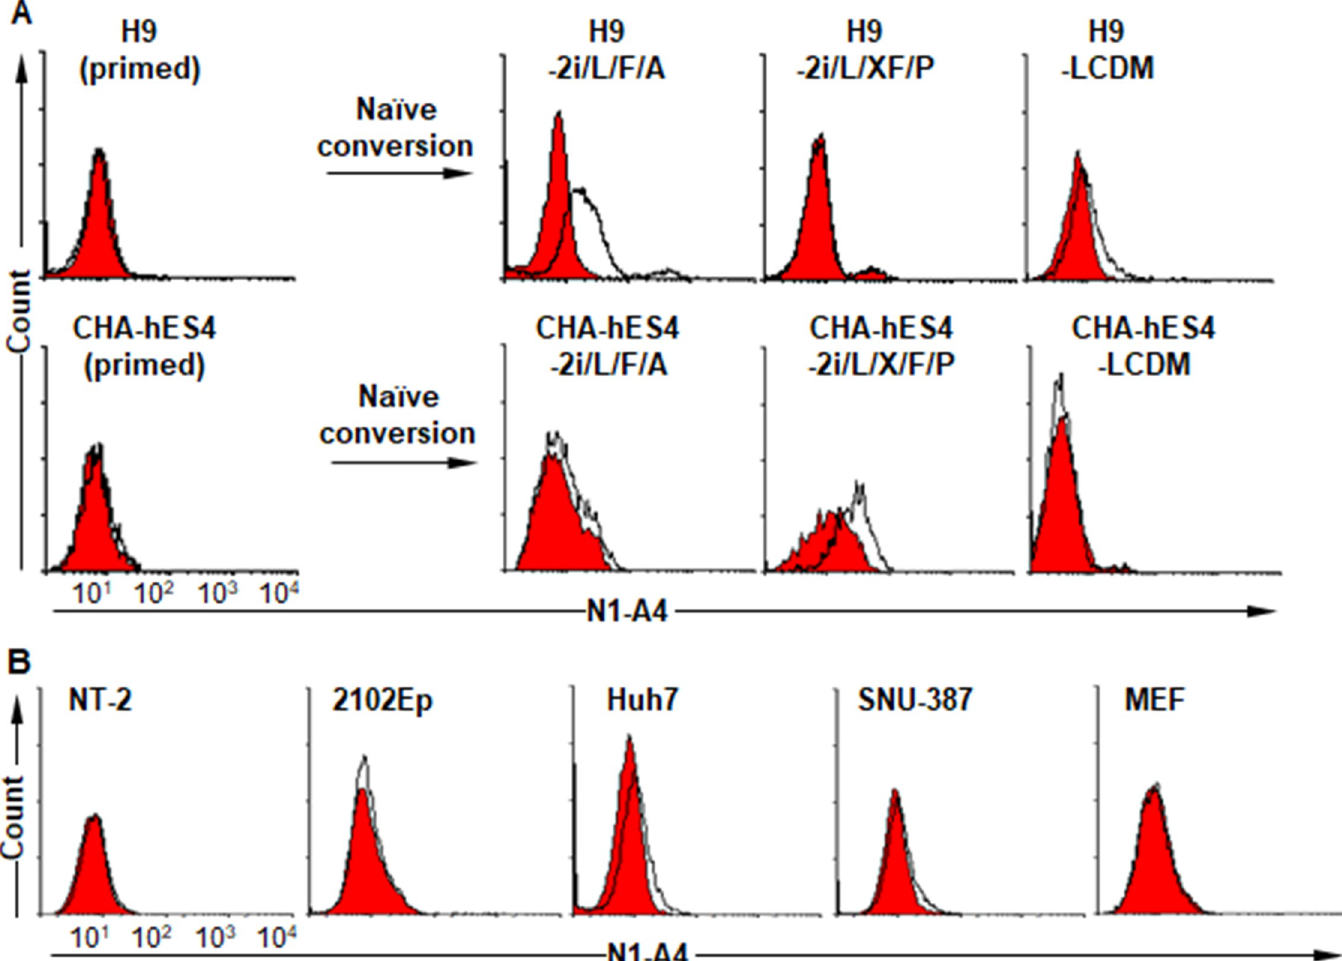
Fig 2. Binding profiles of N1-A4 on primed/na ï ve hPSCs and various cells. (A, B) Expression of N1-A4 antigen was examined by flow cytometry in primed and na ï ve hPSCs (A), human embryonic carcinoma cells (NT-2/D1, 2102Ep), hepatocellular carcinoma cells, (Huh7, SNU-387), and MEFs (B). Black lines, cell surface marker with the indicated primary antibody; red area, no primary antibody